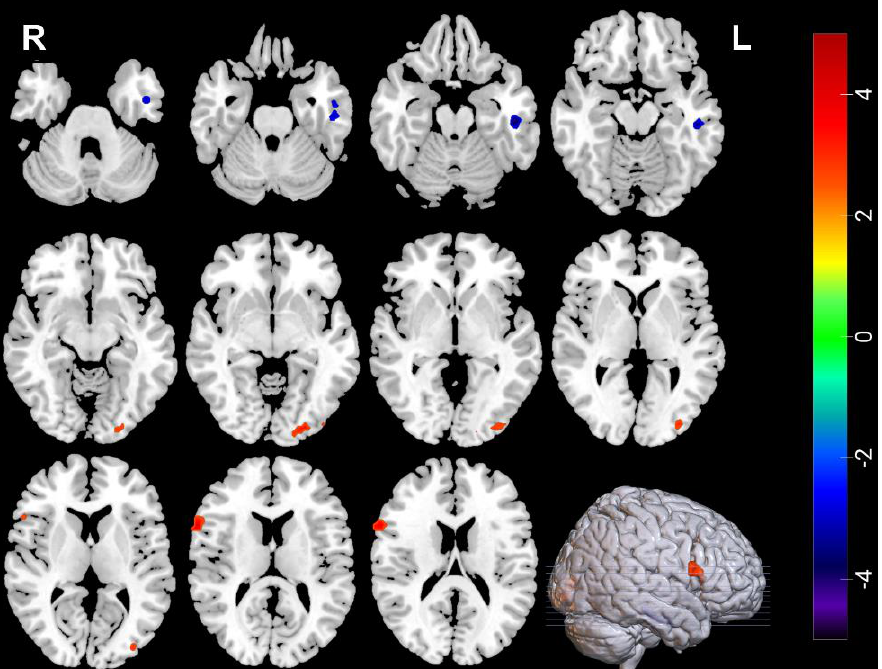
Figure 2. The blue regions represent decreased ReHo in MDDs at baseline compared with HCs in Temporal_Inf_L, the red regions represent increased ReHo in MDDs at baseline compared with HCs in Frontal_Inf_Oper_R and Occipital_Mid_L. ReHo voxel p < 0.005; GRF correction p < 0.05; cluster size > 34.